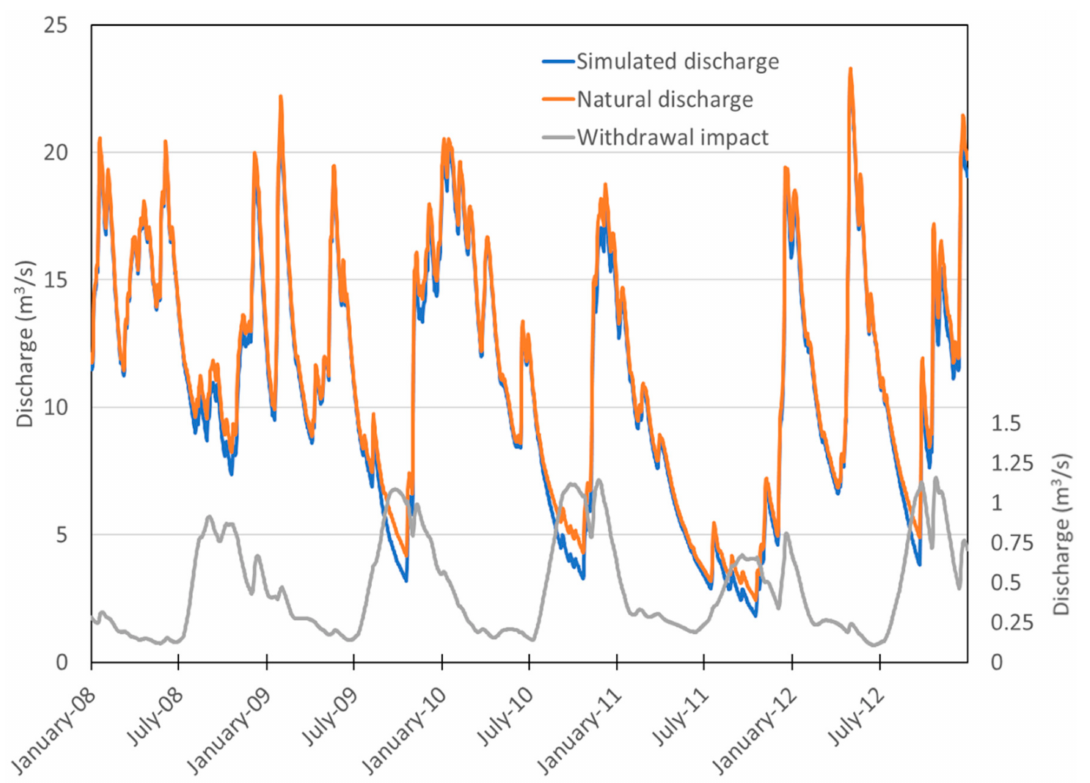
Figure 8. Impact of the naturalization procedure on the discharge at the outlet of the